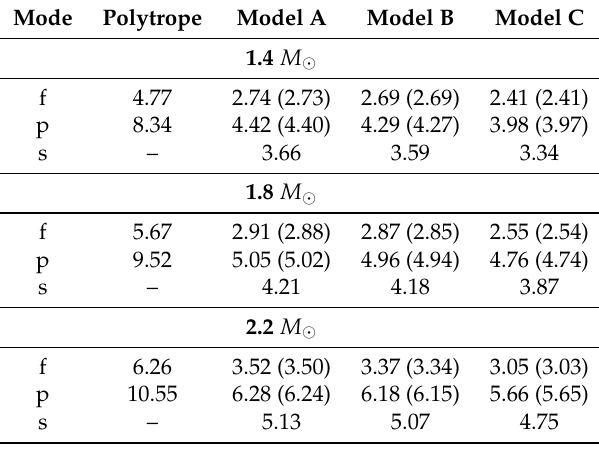
Table 1. Mode Frequency in kHz ( l =